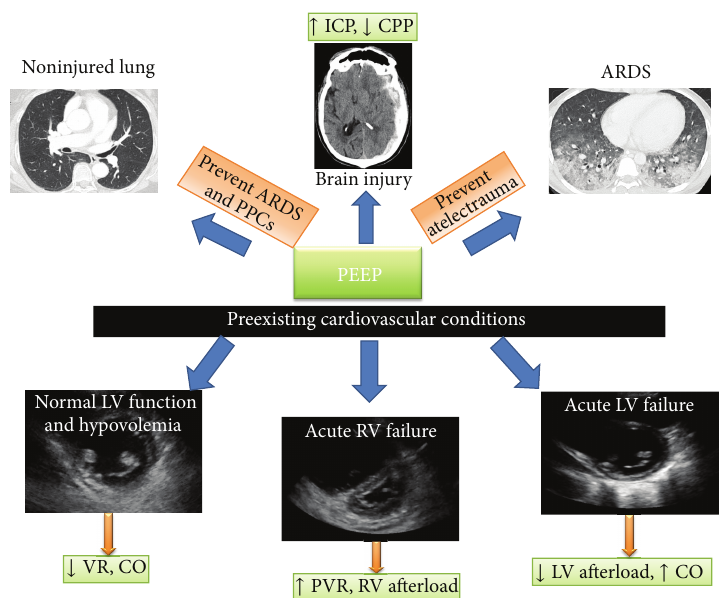
Figure 1: Impact of PEEP on lung and hemodynamic and cerebral perfusion pressure. PEEP: positive end expiratory pressure, ICP: intra- cranial pressure, CPP: cerebral perfusion pressure, ARDS: acute respiratory distress syndrome, LV: left ventricular, RV: right ventricular, VR: venous return, CO: cardiac output, PVR: pulmonary vascular resistance and PPCs: Postoperative Pulmonary